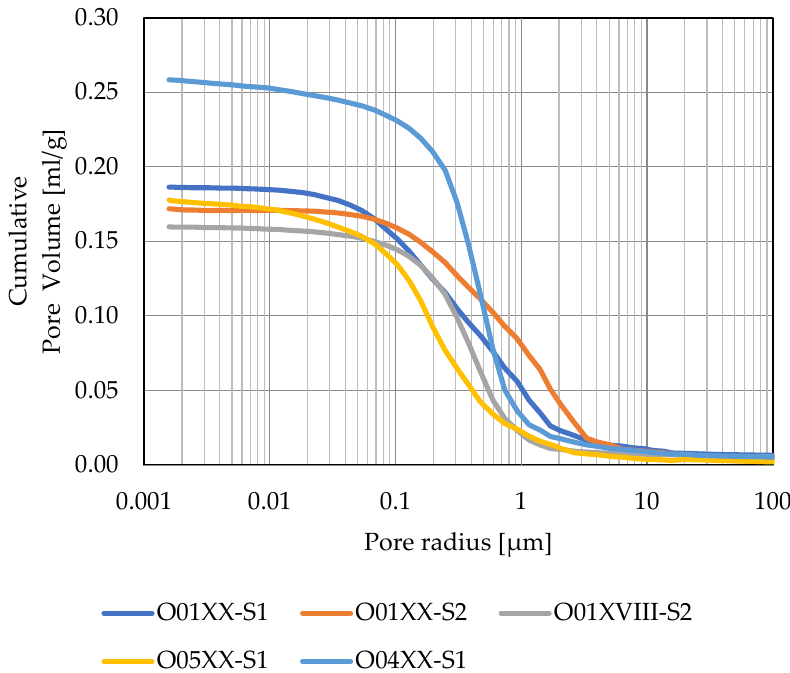
Figure 17. Cumulative pore volume from the MIP test.